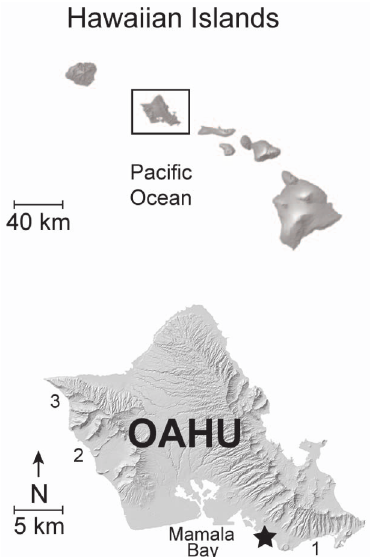
Figure 1. Map of the island of Oahu showing study area along Waikiki Beach. Box jellyfish, Alatina moseri , were collected monthly from 1998–2011 at Waikiki Beach, which is represented by the star symbol. Numbers indicate beach areas along leeward Oahu where A. moseri medusae arrive sporadically: 1) Hanauma Bay, 2) Pokai Bay, 3) Yokohama